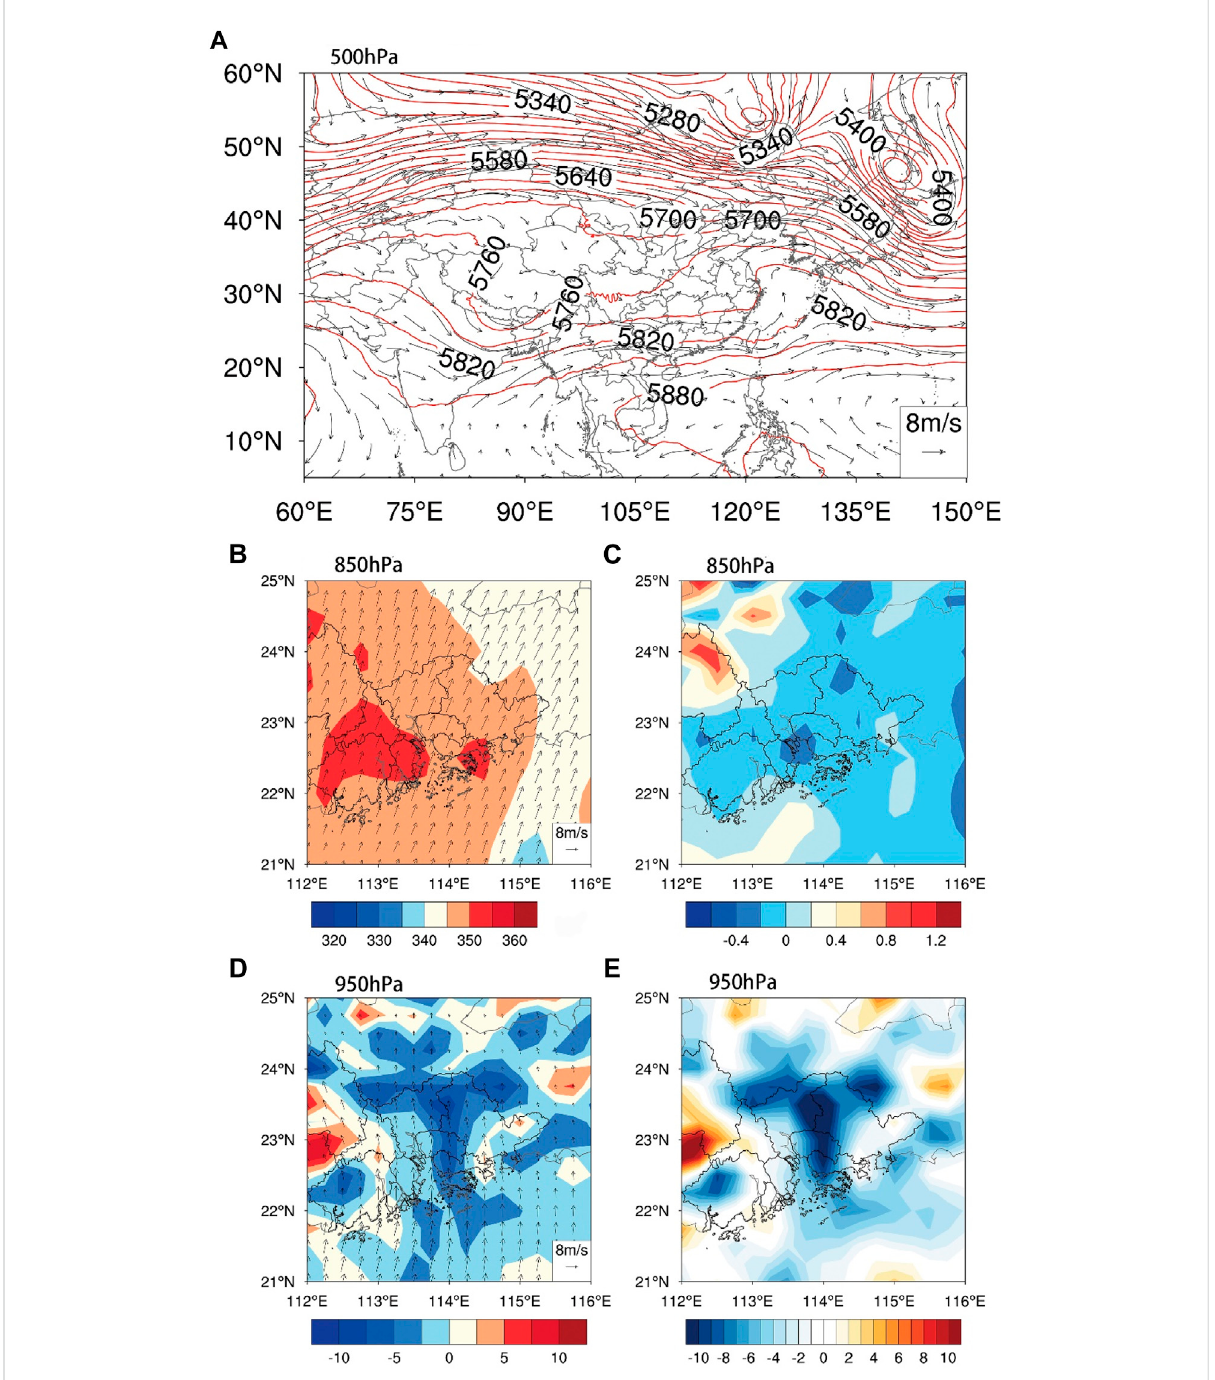
FIGURE 3 The (A) geopotential height (red contours; unit: gpm) at 500 hPa, (B) pseudo-phase temperature (color shading; unit: K) and horizontal wind (arrows; unit: m · s − 1 ) at 850 hPa, (C) 850 hPa relative vorticity fi eld (color shading; unit: s − 1 ), (D) 950 hPa horizontal wind (arrows; unit: m · s − 1 ) and horizontal divergence of velocity fi eld (color shading; unit: s − 1 ), and (E) 950 hPa water vapor fl ux divergence fi eld (color shading; unit: 10 g · cm − 1 s − 1 hPa − 1 ) at 0700 LST 20 April